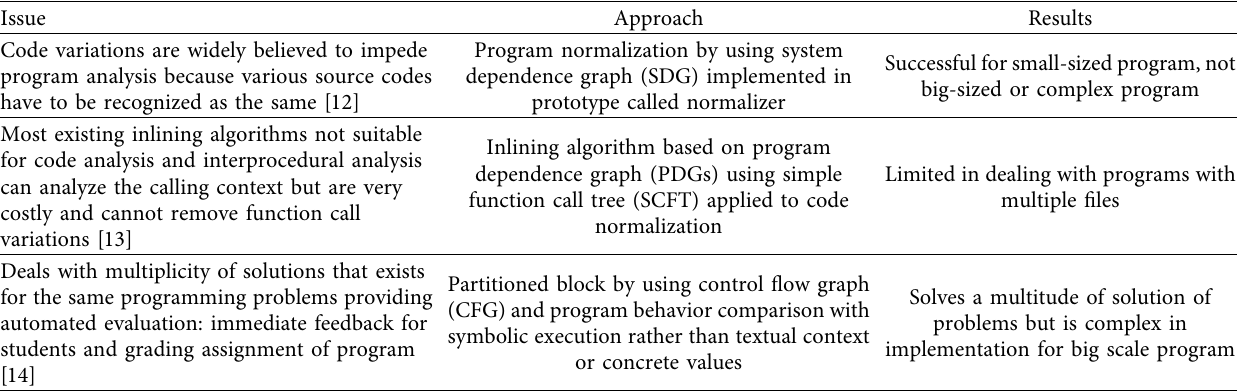
Table 1: Current research issues in automatic grading